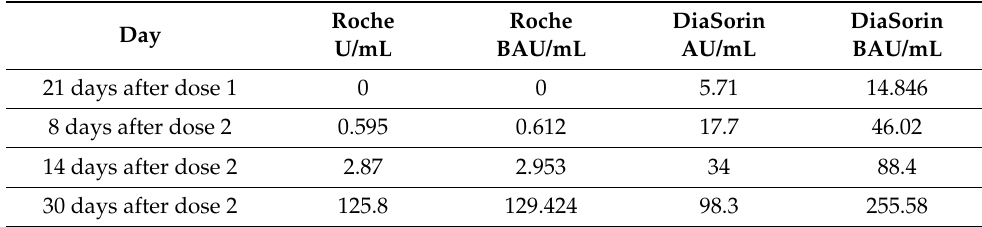
Table 1. Roche and DiaSorin test result for samples up to day 30 after dose 2.